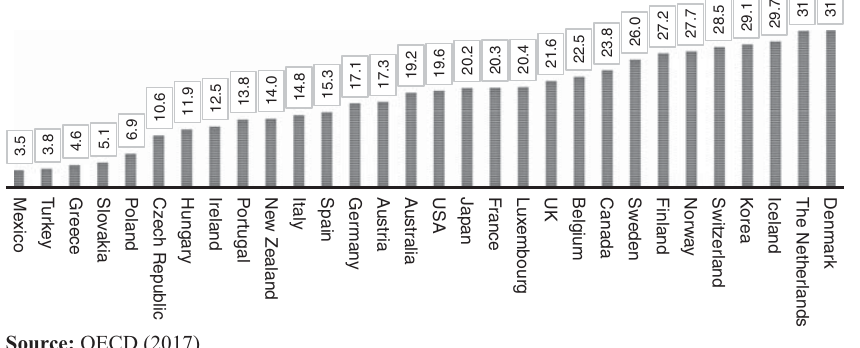
Figure 2. Broadband